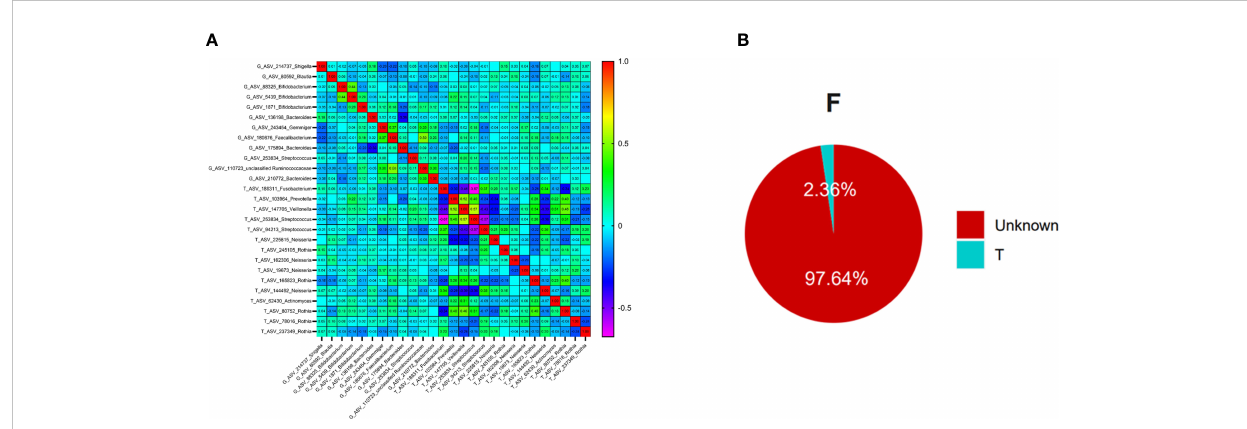
FIGURE 5 The relationships between oral fl ora and intestinal fl ora in T2DM (Figure (A) is the correlation beatmap between oral fl ora and intestinal fl ora, Figure (B) is the results of the Source Tracker, F represents the feces samples, and T represents the tongue-coating